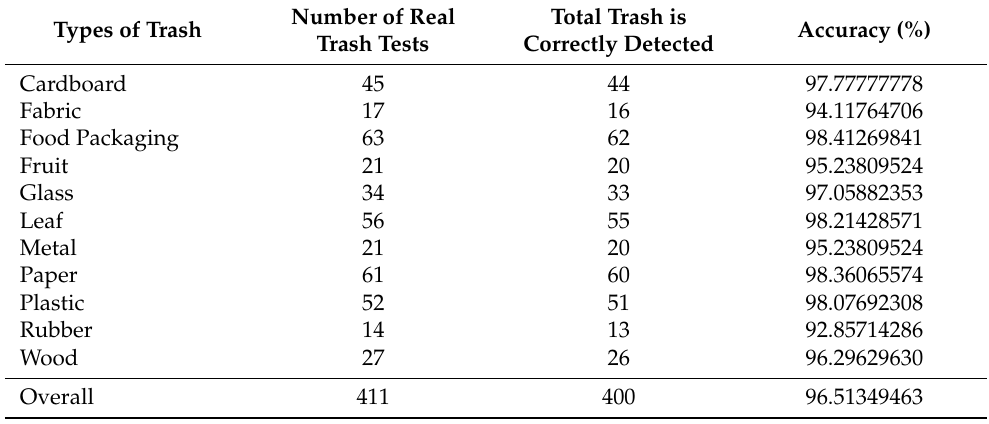
Table 8. The Accuracy of 11 Types of Trash Using a Real-Time Camera with Pre-Trained GoogleNet.